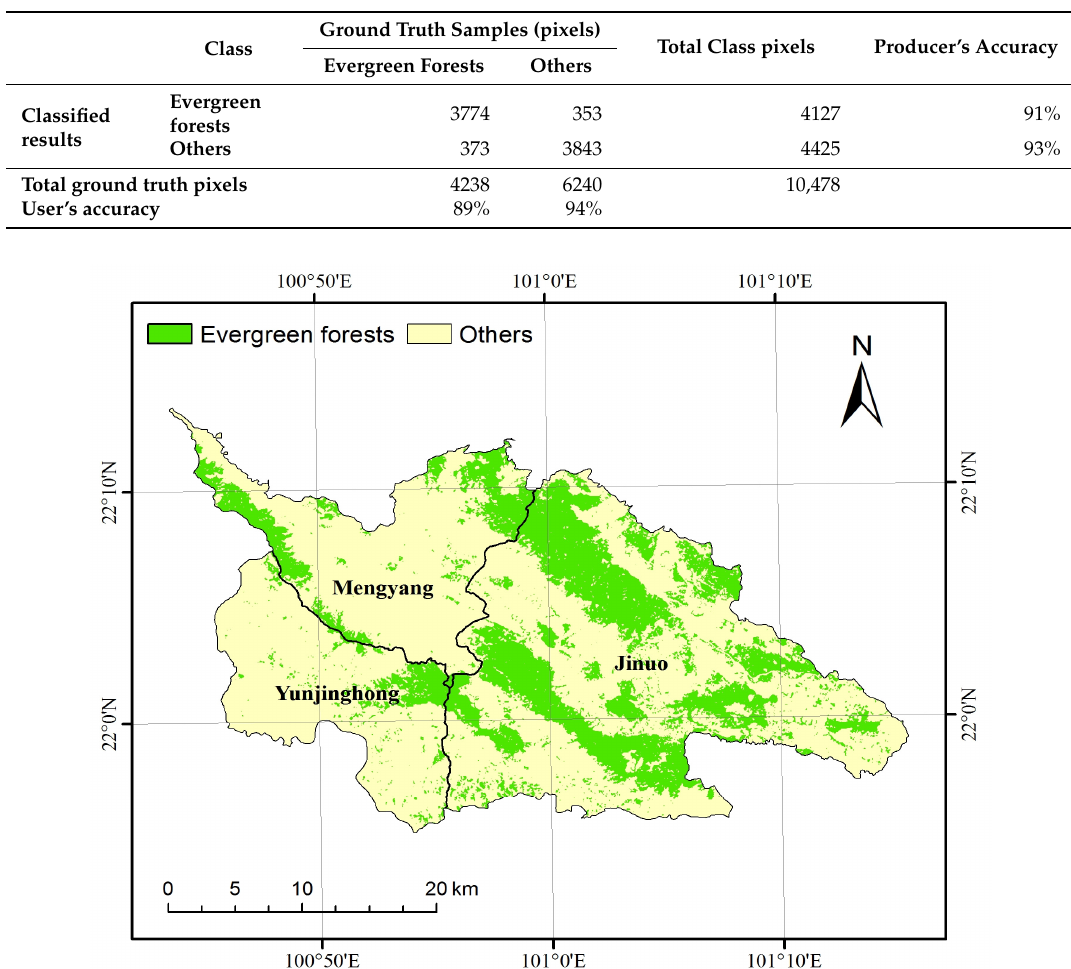
Figure 5. The 30-m Landsat-based map of tropical evergreen forest of the study area in Xishuangbanna, Yunnan, China in 2010.